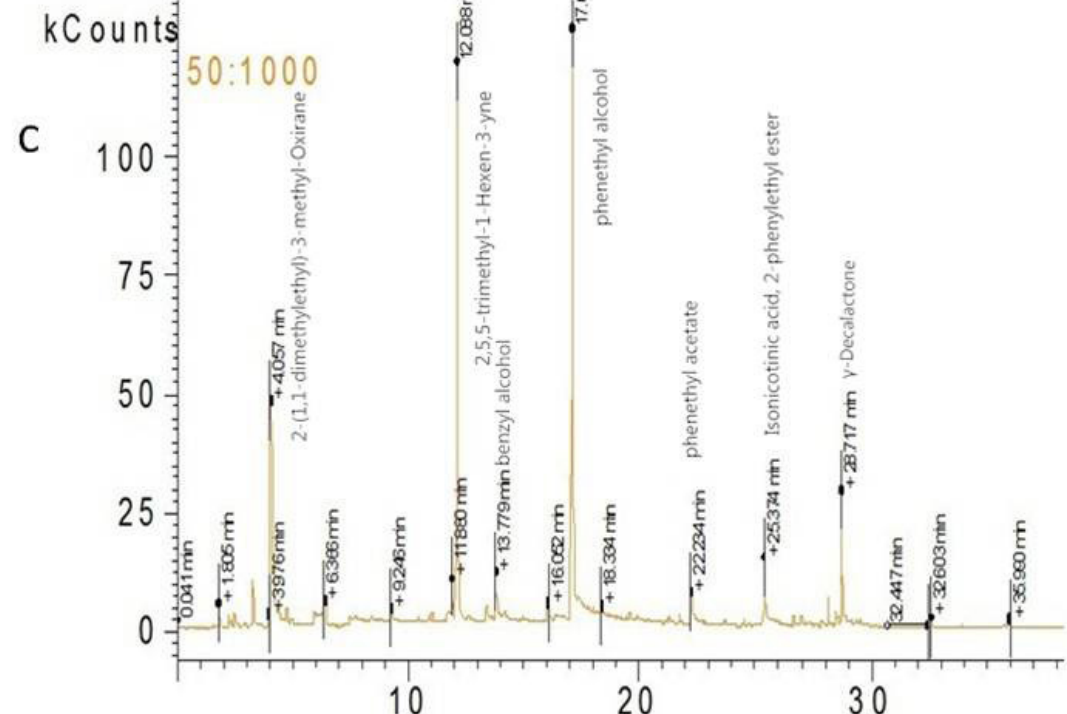
Fig 3 . Gas chromatography–mass spectrometry (GCMS) total ion chromatography of fungal mycelia (mummies) from PDA medium of Ascosphaeraapis by solid phase microextraction (SPME)